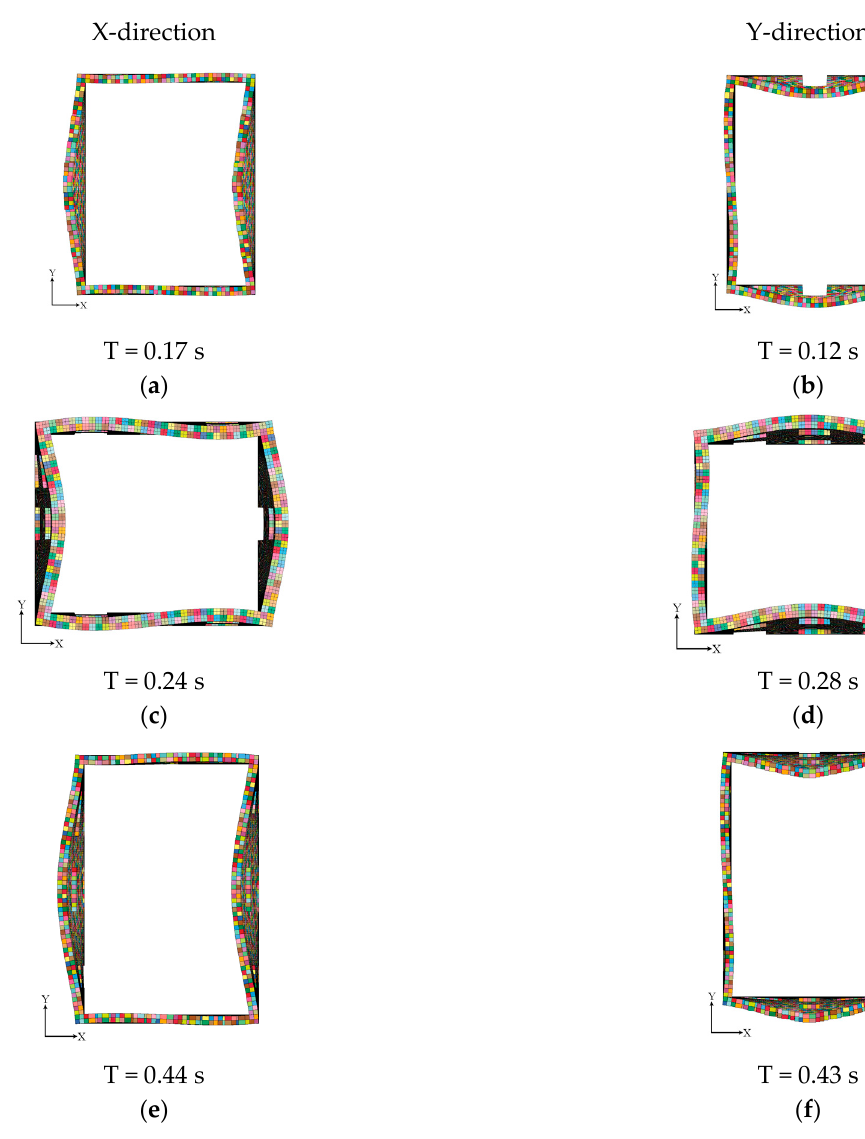
Figure 11. Fundamental periods of vibration and the corresponding modes for translation in X-direction and Y-direction: ( a , b ) building 1; ( c , d ) building 2; ( e , f ) building 3.